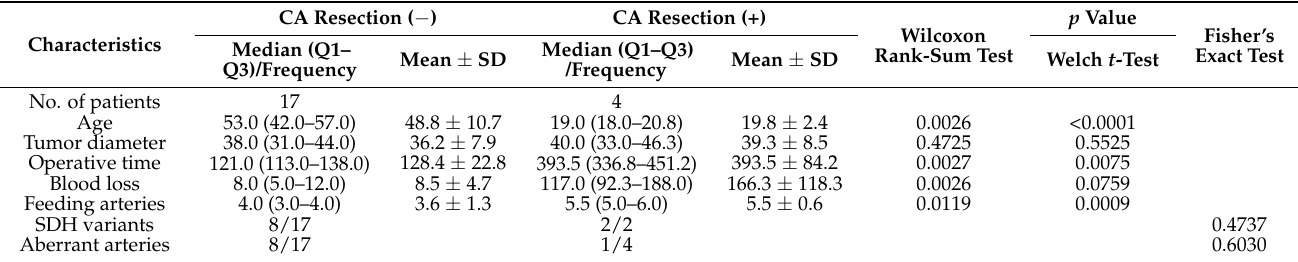
Table 3. Analyses of the relationship between clinical factors and carotid artery resection.